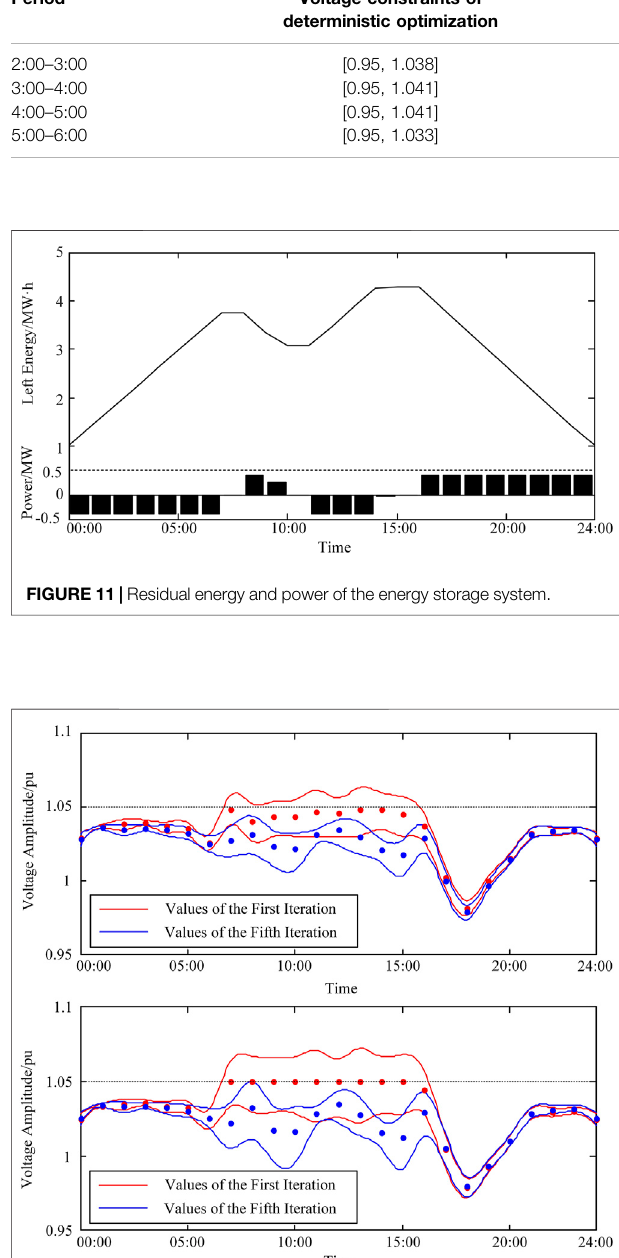
Frontiers in Energy Research |